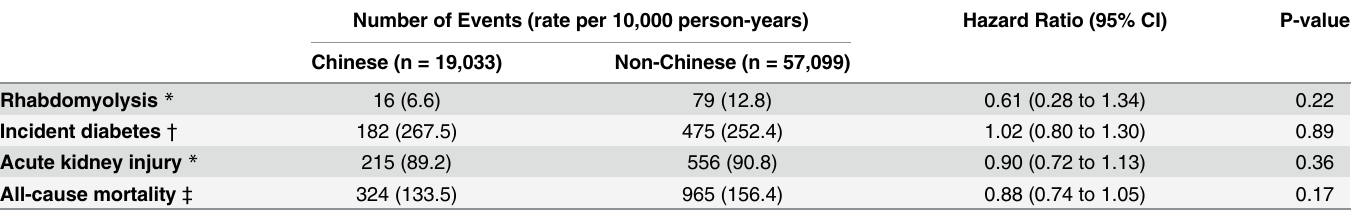
Table 2. Statin-associated adverse outcomes in Chinese and non-Chinese